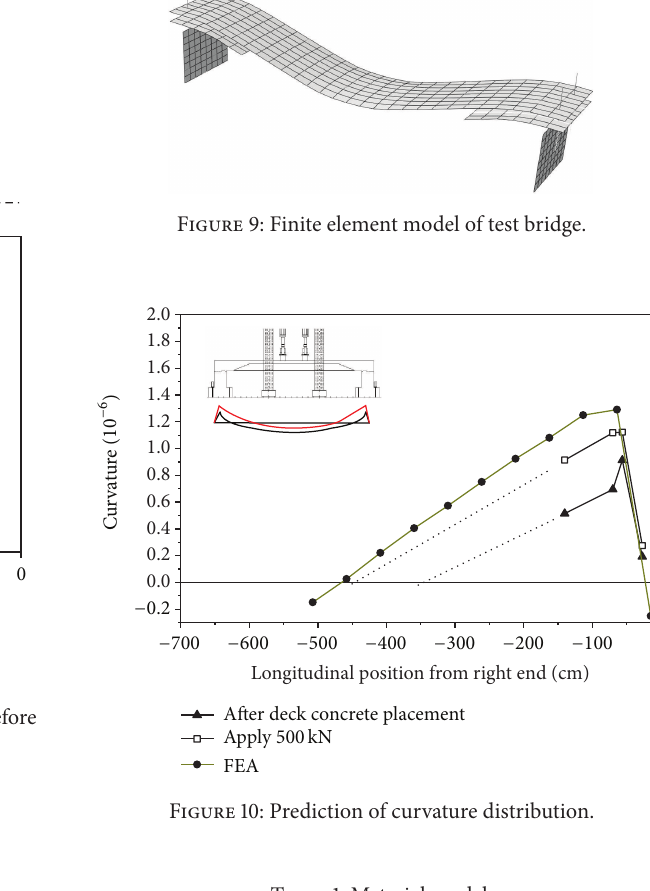
Table 1: Material